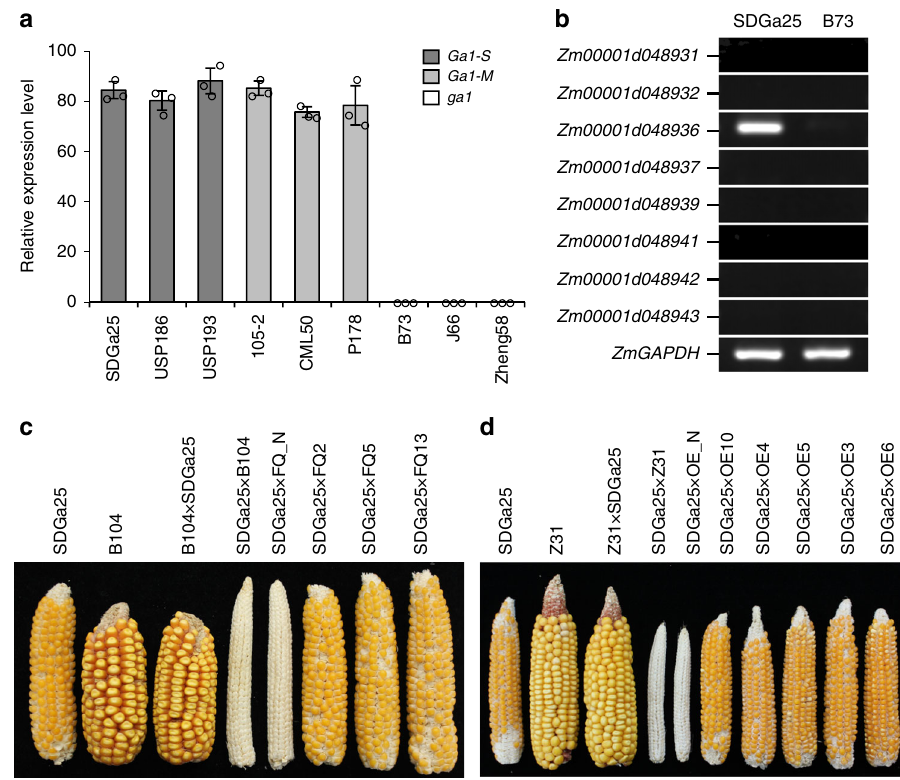
Fig. 2 Validation of Zm00001d048936 as a pollen determinant. a Quantitative expression analysis of Zm0001d048936 in pollen of Ga1-S , Ga1-M , and ga1 lines. Error bars represent the mean ± SD ( n = 3). b Examination of the eight candidate gene expression in pollen of SDGa25 ( Ga1-S ) and B73 ( ga1 ). ZmGAPDH was used as an internal control. c , d Cross-compatibility analyses, showing ears of self-pollinations and reciprocal crosses between the SDGa25 ( Ga1-S ) and B104 or Z31 ( ga1 , control plants). The SDGa25 ears pollinated with non-transgenic controls (FQ_N and OE_N) and transgenic plants expressing ZmGa1P . c Transgenic plants made with the construct shown in Supplementary Fig 7a, d T 2 generation of transgenic plants made with To determine whether Zm00001d048936 has female function, the fi ve T 2 OE lines that exhibited high level of Zm00001d048936